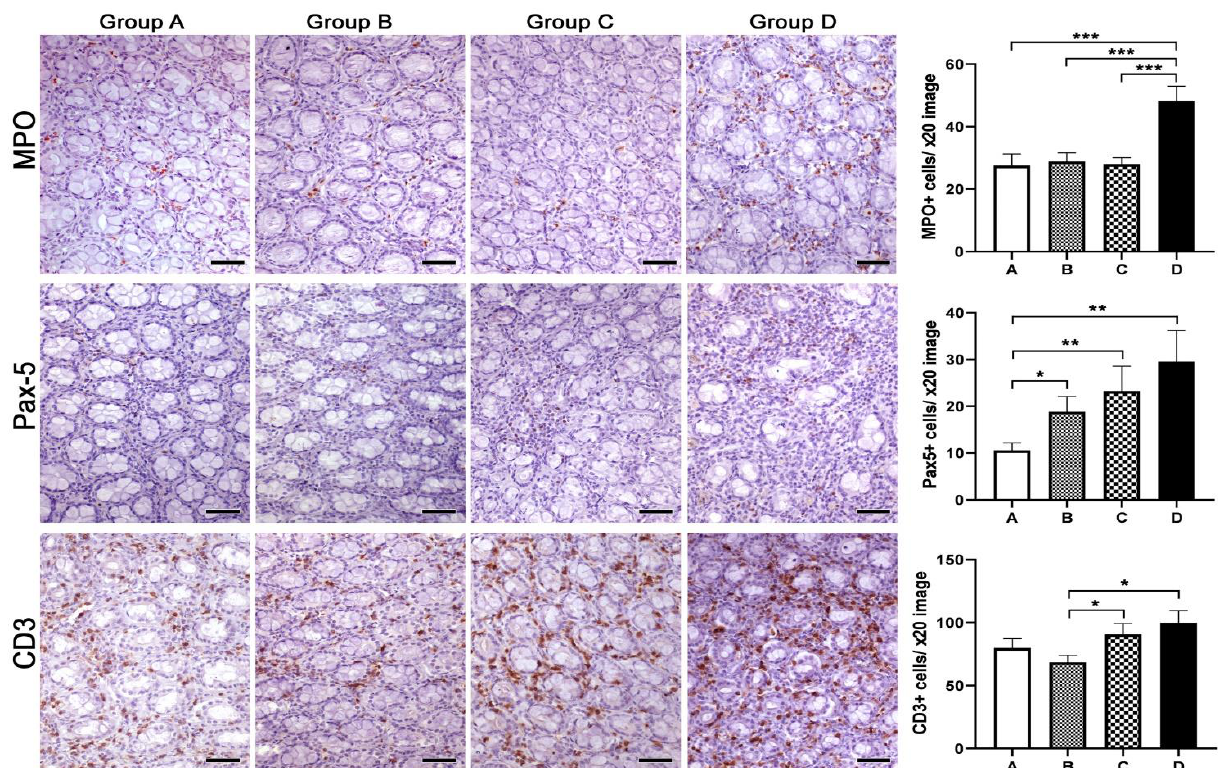
Figure 6. Effects of Spirulina treatments on inflammatory cells in the colonic mucosa of mink progeny. A Spirulina diet in progeny (group C), mothers (group B) or both (group A) worked to reduce the load of granulocytes (MPO), B-lymphocytes (PAX-5) and T-lymphocytes (CD3) in the colonic mucosa lamina propria in comparison to untreated controls (group D). Morphometric counts of immunohistochemically labeled inflammatory cells yielded statistically significant differences among experimental groups, as shown in the bar graphs. IHC: diaminobenzidine chromogen, hematoxylin counterstain. Scale bars: 50 μm. Numbers on the y -axes of bar graphs corre- spond to the means ± SEM of immune cell counts * p < 0.05, ** p < 0.01, *** p < 0.001. Letters of the x- axes correspond to the experimental groups (A, B, C, D).